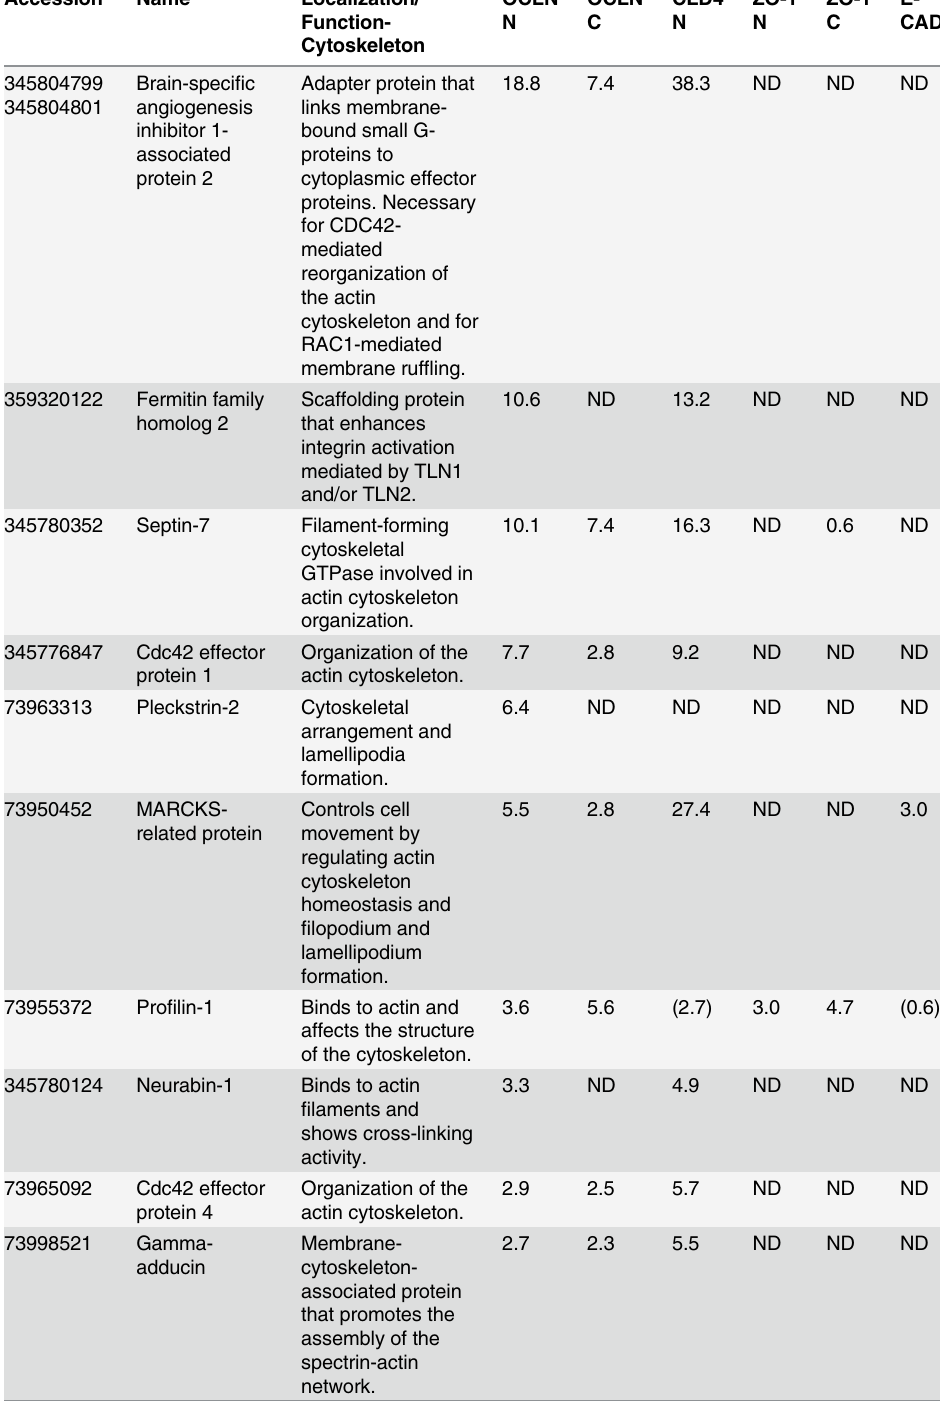
Table 7. Enriched cytoskeletal proteins tagged by biotin ligase fused to occludin and